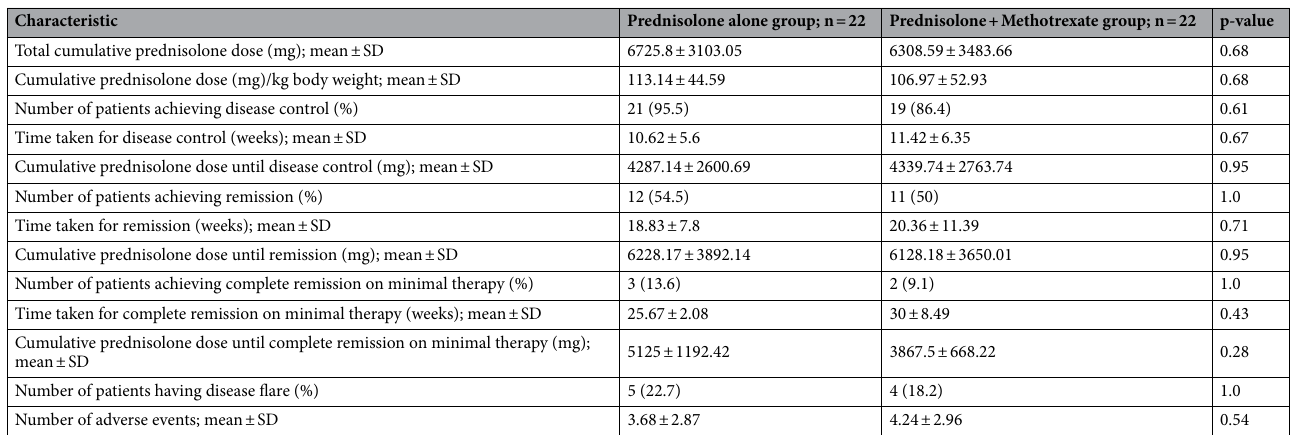
Table 2. Comparison of outcome measures between the